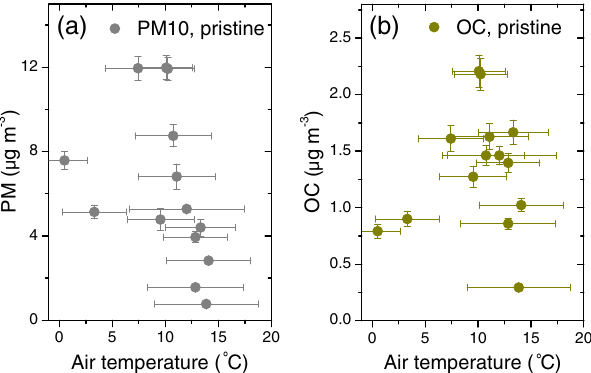
Figure 14. PM 10 (a) and OC (b) concentration during pristine sum- mer periods vs. averaged ground-level temperature ( ± SD) esti- mated from the meteorological profiles along each trajectory.